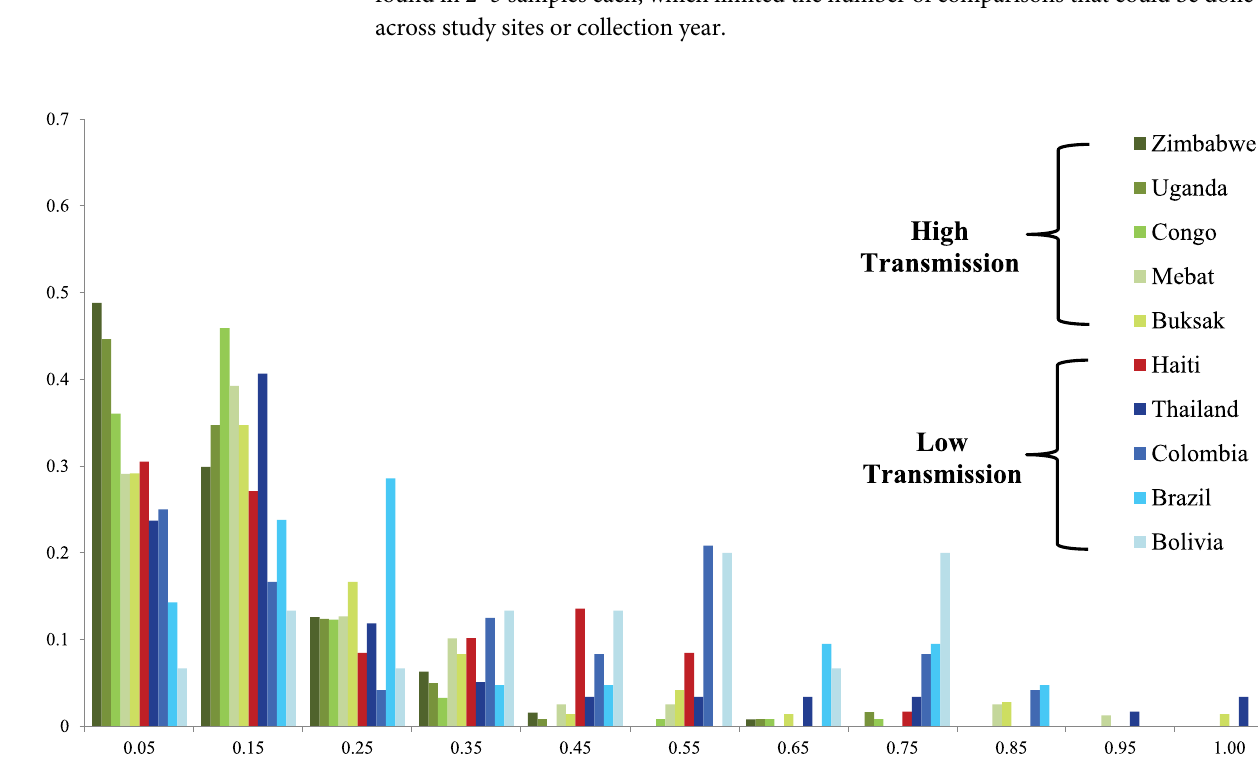
unique allele (data not shown). TA60 had two private alleles only observed in Terre Noire. Most private alleles were detected only in a single individual with the exception of the TA40 199 allele, which was observed in four individuals from Jacmel. We examined the number of microsatellite haplotypes in our study, excluding samples with any missing genotypes or greater than two alleles at any locus. Of 76 eligible samples, 62 haplo- types were observed (data not shown). Seven haplotypes were observed in more than one sam- ple, while the remaining 55 haplotypes were only observed once. One haplotype was detected in six samples across two study sites (H1; Terre Noire = 5, Leogane = 1) and across three collec- tions years (2010 = 2, 2011 = 1, and 2012 = 3). The other multiple sample haplotypes were found in 2 – 3 samples each, which limited the number of comparisons that could be done across study sites or collection year.